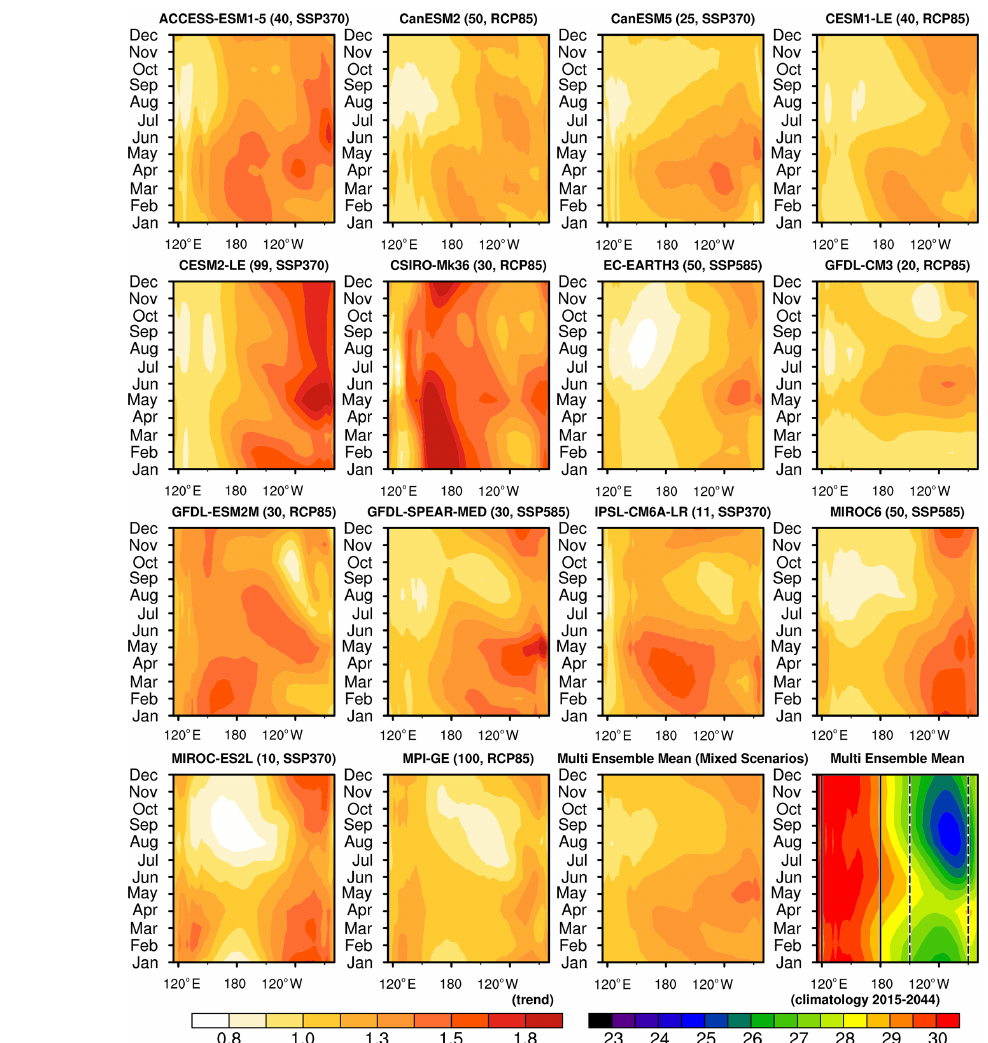
Figure 6. Longitude–time sections of the ensemble mean linear trend of SST over the equatorial Pacific (5 ◦ S–5 ◦ N) during 2015–2099 normalized by the global mean SST trend. The bottom right panel shows the multi-ensemble mean climatological seasonal cycle of SST in the equatorial Pacific over 2015–2044. Vertical black lines delineate the averaging regions used in Figs. 7–10, with the solid lines indicating the western Pacific region and the dashed lines indicating the eastern Pacific